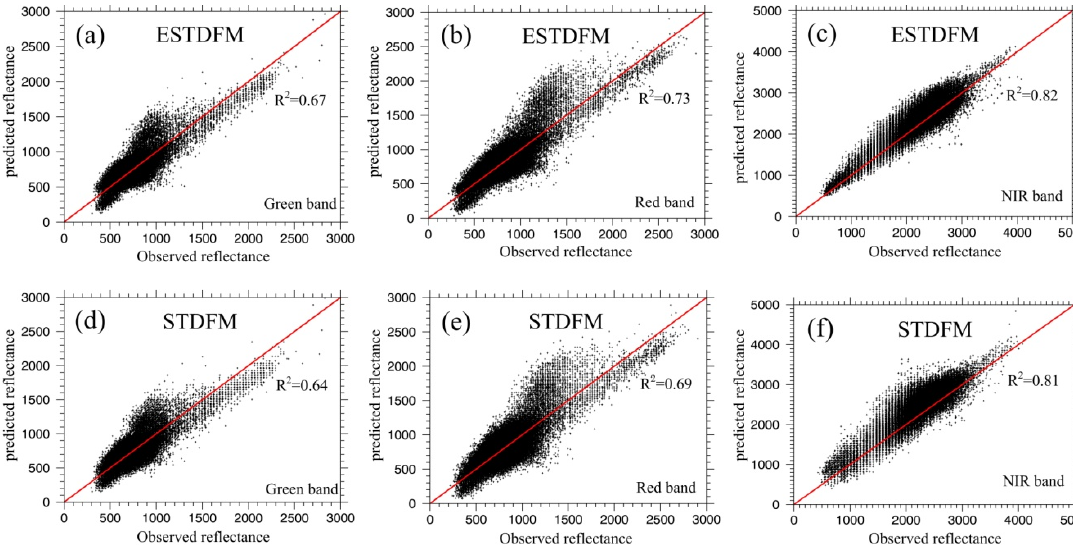
Figure 7. Scatter Plots between the reflectance of the actual ETM+ image on 24 October and the reflectance of the predicted image by ESTDFM ( a – c ), the reflectance of the predicted image with STDFM ( d – f ) for green, red, and NIR band (scale factor =